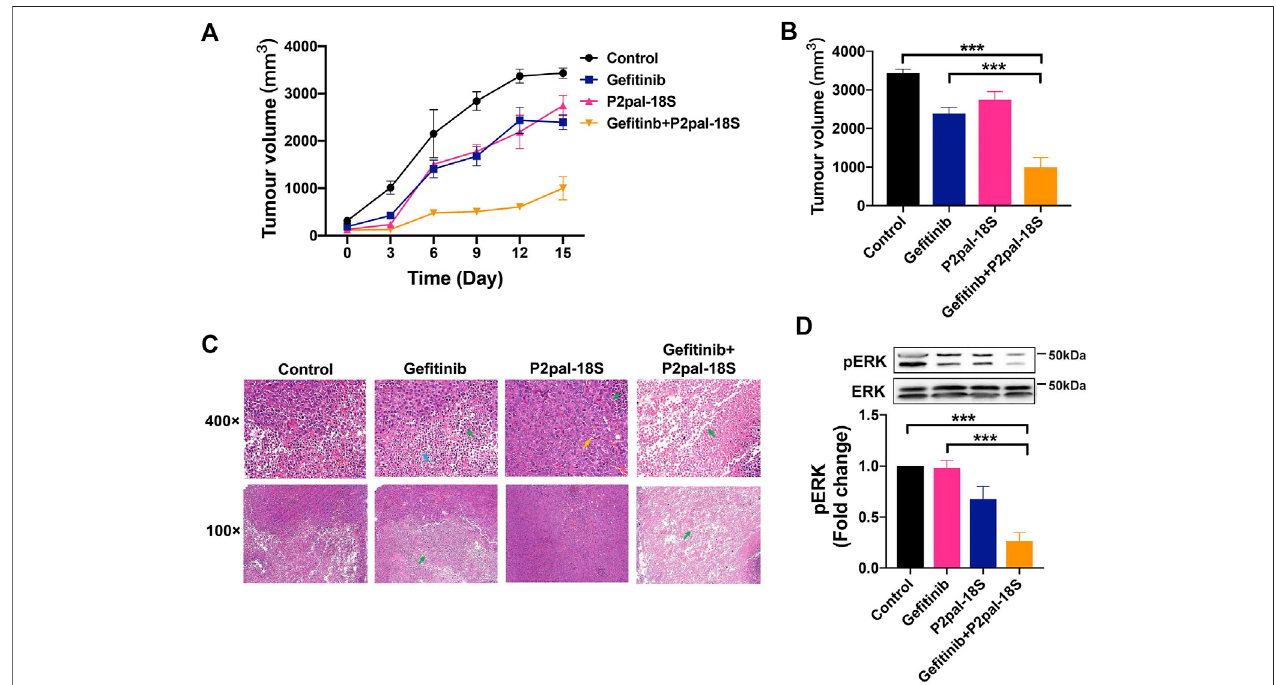
FIGURE 5 | PAR2 inhibition reactivated ge fi tinib to inhibit tumor growth via ERK signaling in vivo . (A) . The combination of P2pal-18S and ge fi tinib signi fi cantly attenuatedPC-9-GRtumorgrowth; (B) .P2pal-18Spromotedge fi tinibtodecreasetumorgrowthwhereasge fi tinibexhibitedlittleinhibitoryeffects; (C) .TheH&Estaining analysis of tumor tissues with different treatments were detected; (D) . P2pal-18S facilitated ge fi tinib to inhibit phosphorylation of ERK in PC-9-GR tumor tissues. Tumor cell necrosis (green), blood capillary (yellow), neutrophil (blue), *** p <